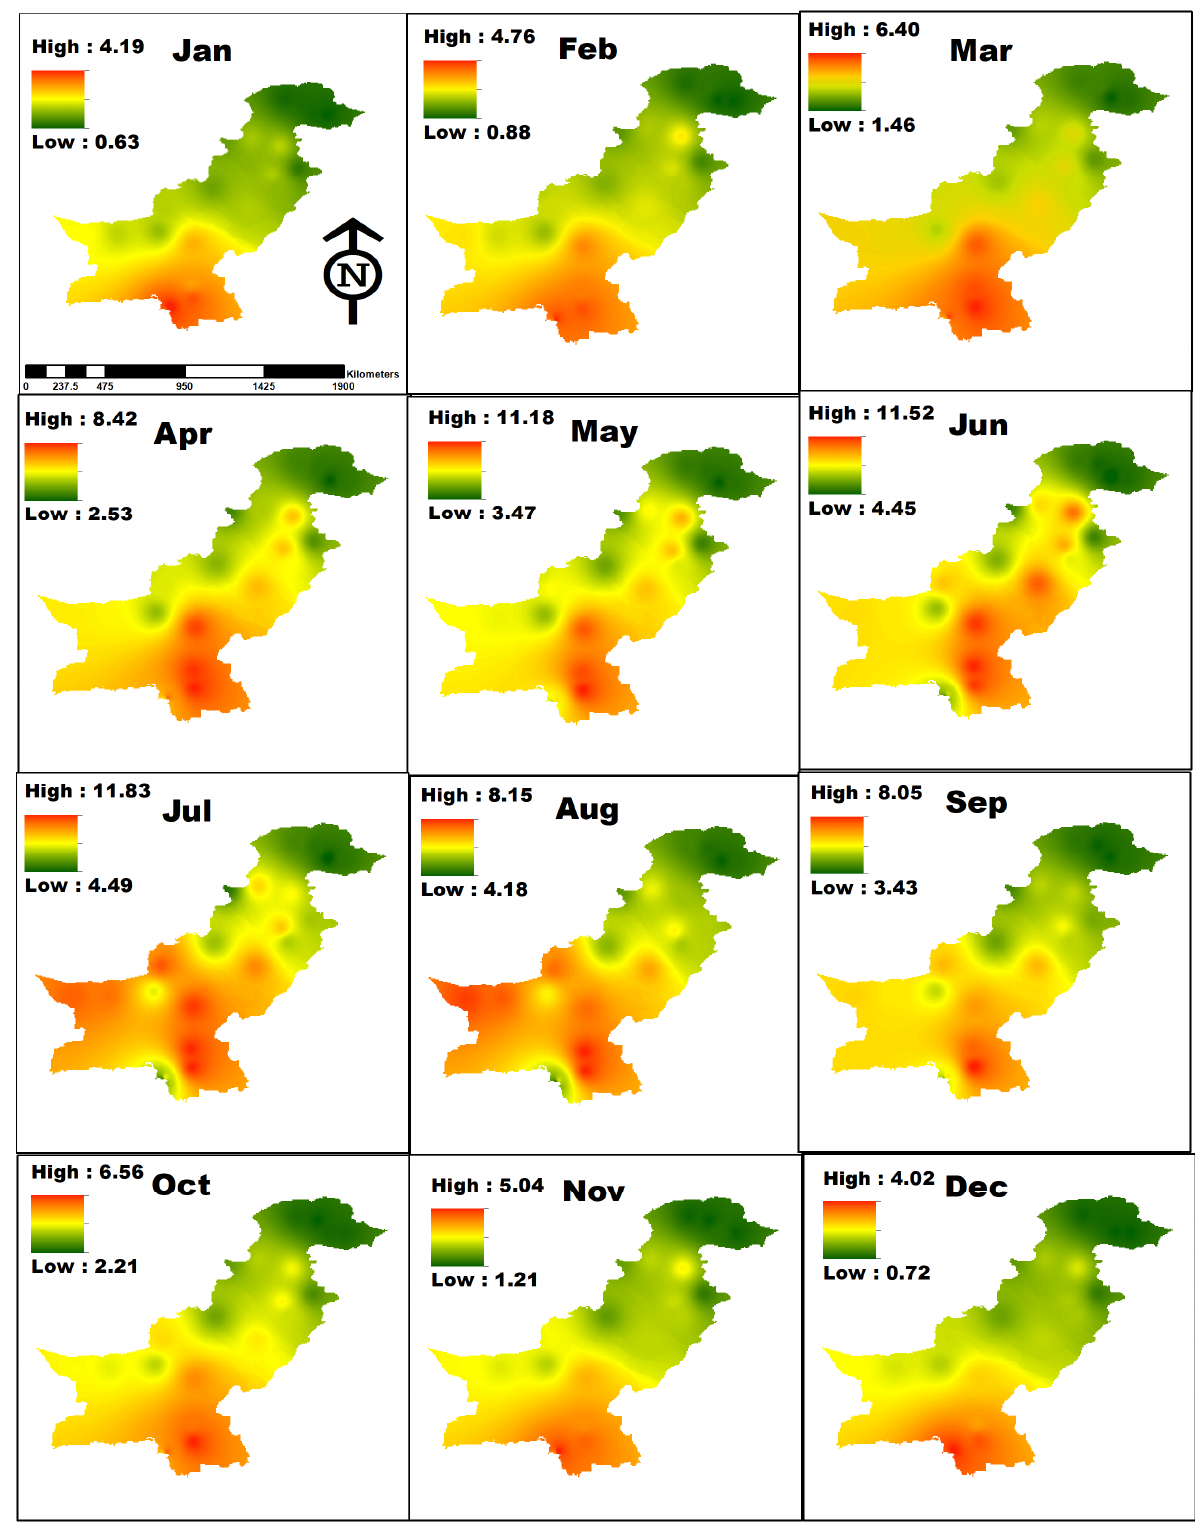
Figure 11. Monthly (Jan-Dec) ET o map of Pakistan based on geographic data.